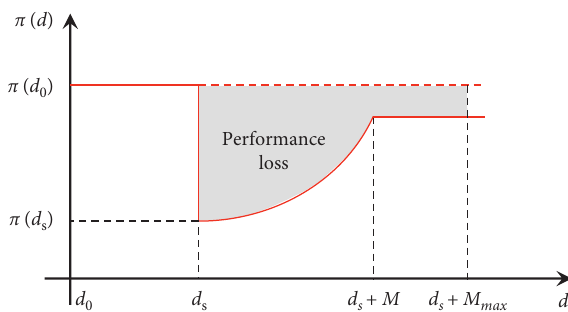
Figure 1: Postdisaster network performance recovery